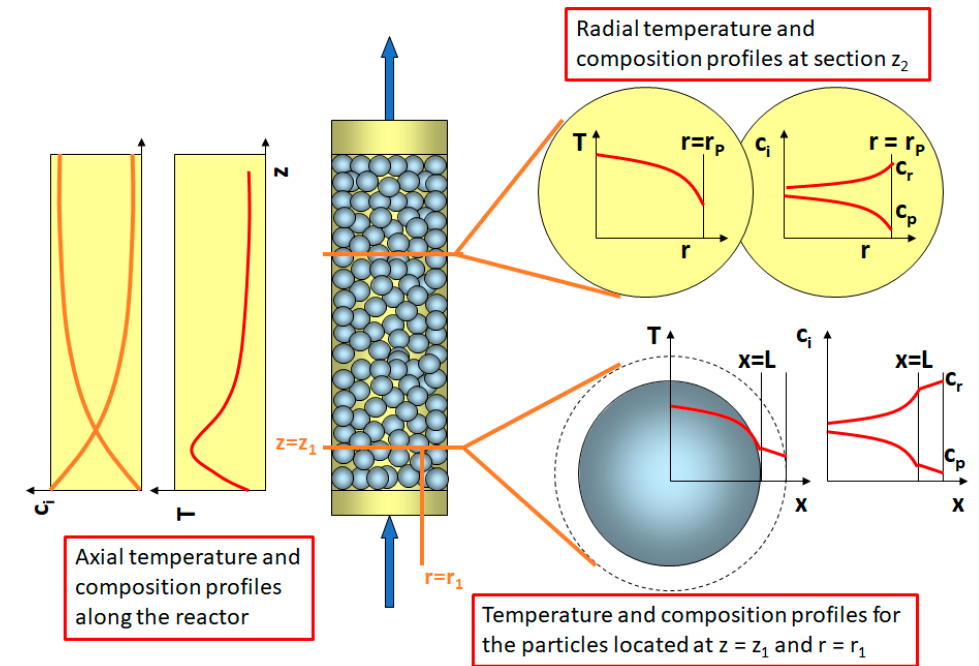
Figure 1. Overview of temperature and concentration macroscopic and microscopic gradients in packed bed reactor (taken and adapted from [1]). Reprinted with the permission of Springer, Copyright 2018.